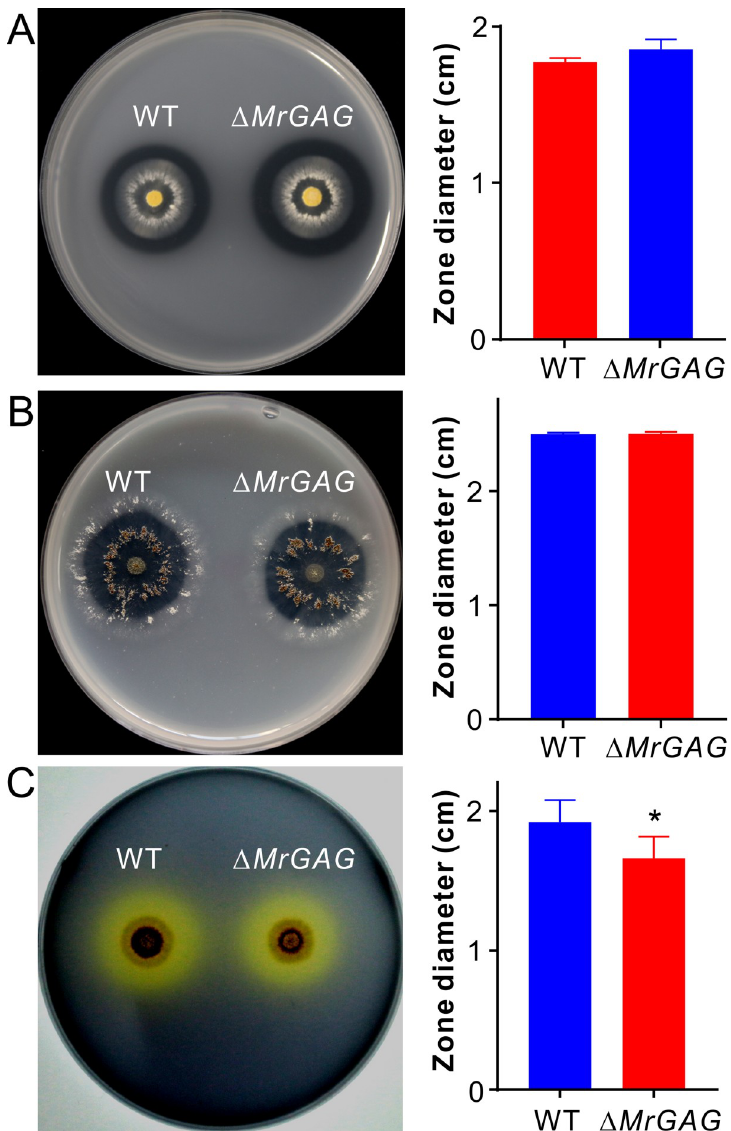
Fig 7. Comparative enzyme hydrolytic activity assays between WT and Δ MrGAG . (A) Non-significant variation between strains in digestion of casein seven days post inoculation. (B) Non-significant variation between strains in digestion of chitin seven days post inoculation. (C) Variation between strains in digestion of olive oil five days post inoculation. The right part of each panel shows the data of the hydrolytic zone diameters formed by WT and Δ MrGAG . The significance of the two-tailed Student’s t -test difference is at: � , P =